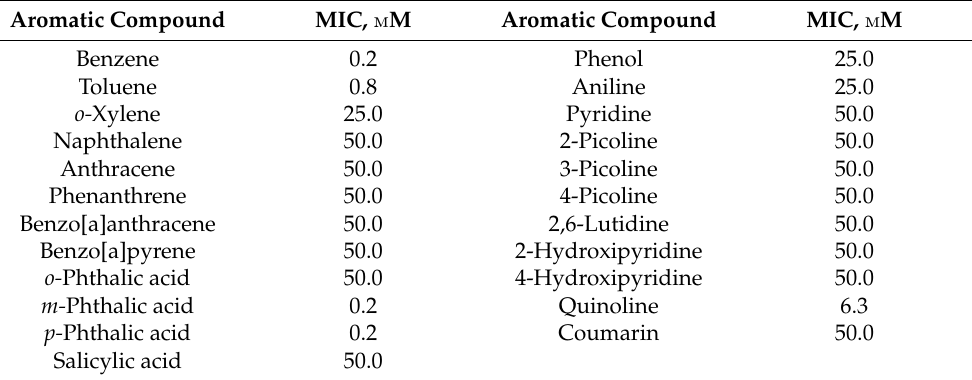
Table 1. Minimal inhibitory concentrations of aromatic compounds for R. ruber IEGM